Question: Write a single sentence explaining what this figure depicts.
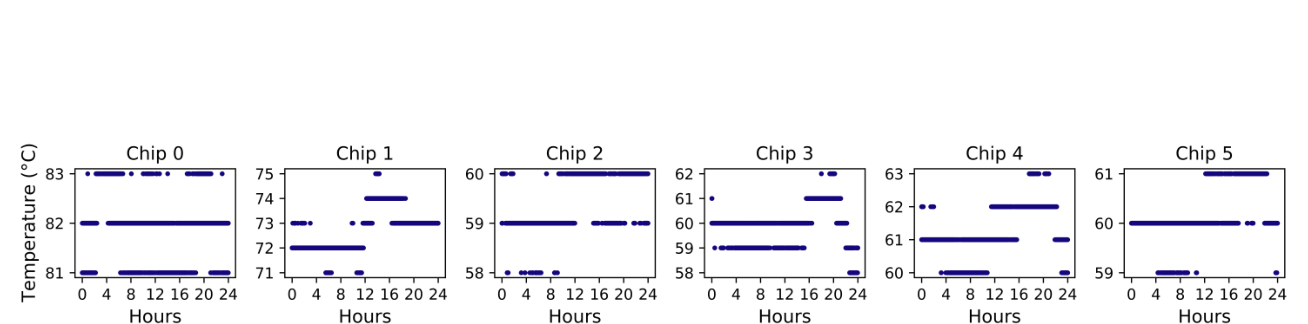
Answer: Tested HBM2 chips’ temperature over time (24 hours). We draw temperature measurements taken every 5 seconds over a 24 hour time window. RowPress test with a hammer count of 10, we activate each of the two aggressor rows 10 times, resulting in a total of 20 row activations. 2) tAggON: The time each aggressor row stays on with each activation during a RowHammer or a RowPress test. 3) Data pattern: We use the four data patterns (Table 1) that are widely used in memory reliability testing [106] and by prior work on DRAM characterization (e.g., [1,4,68,70,107]). For each DRAM row, we define WCDP as the data pattern that causes the smallest HCfirst. When multiple data patterns cause the same HCfirst, we select WCDP as the data pattern that causes the largest BER at hammer count = 256K.